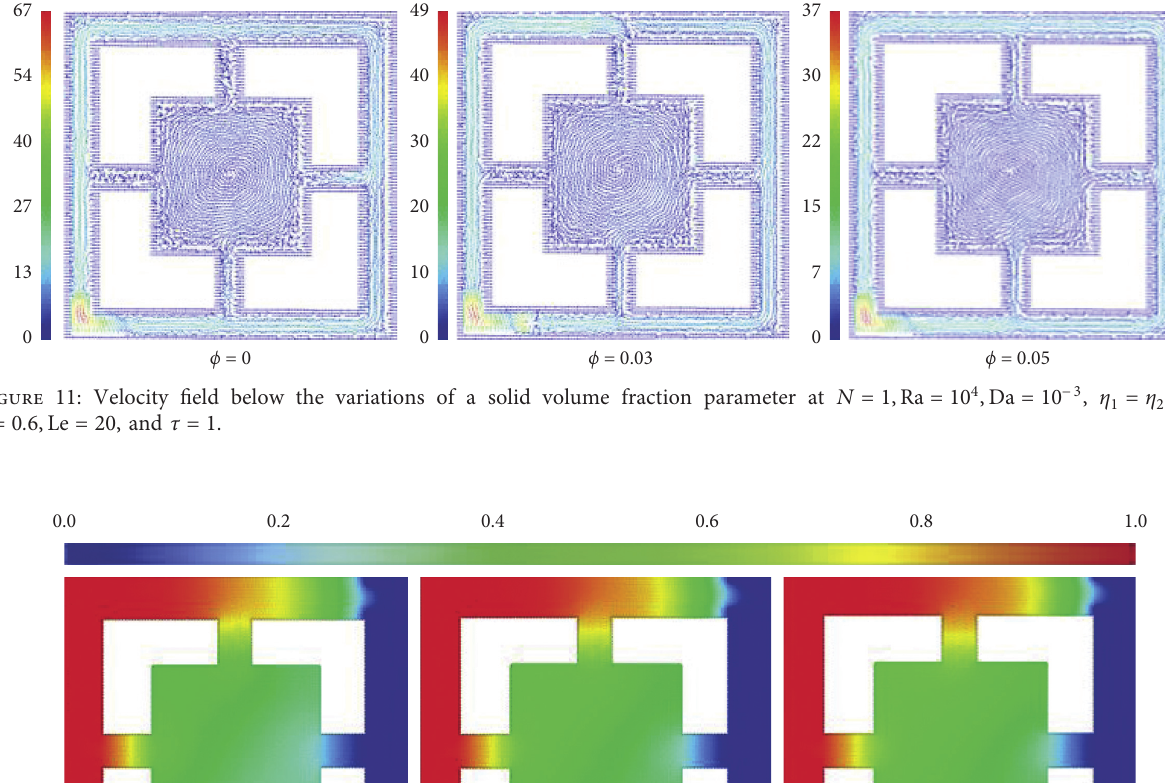
Figure 10: Features of concentration below the variations of a solid volume fraction parameter at N � 1 , Ra � 10 4 , Da � 10 − 3 , η ε � 0 . 6 , Le � 20, and τ � 1.